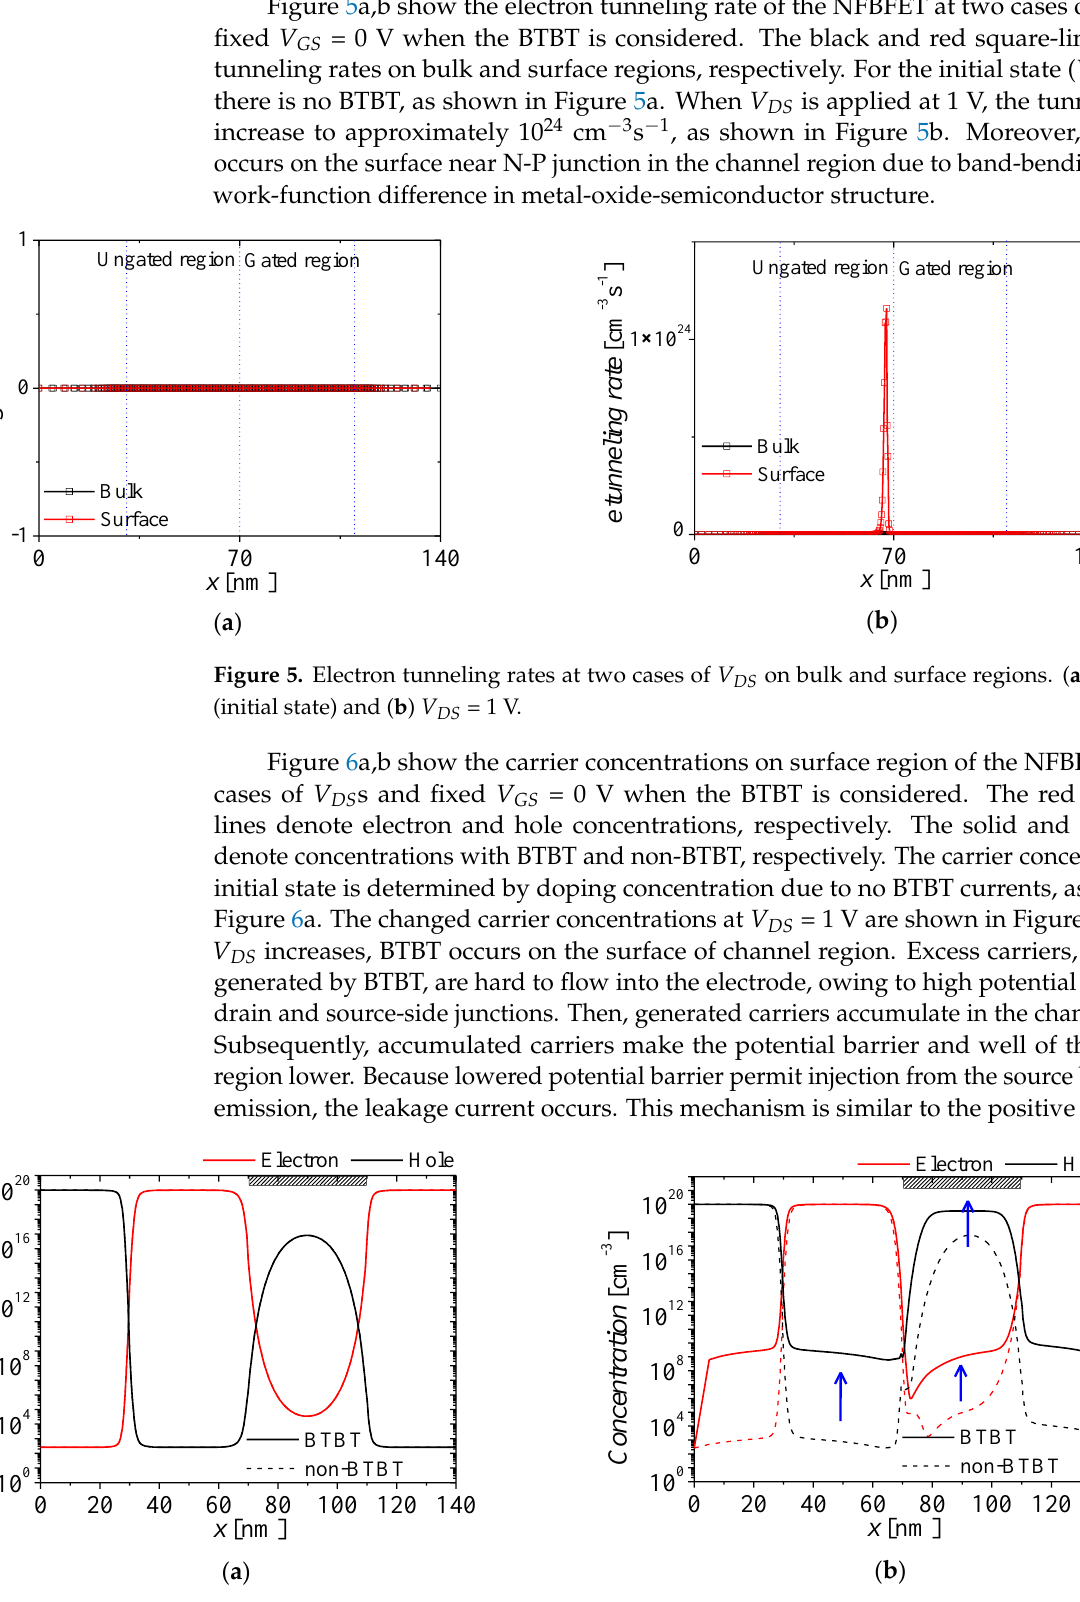
Figure 6. Comparison of carrier concentrations on surface region at two cases of V DS . ( a ) V DS = 0 V (initial state) and ( b ) V DS = 1.0 V.